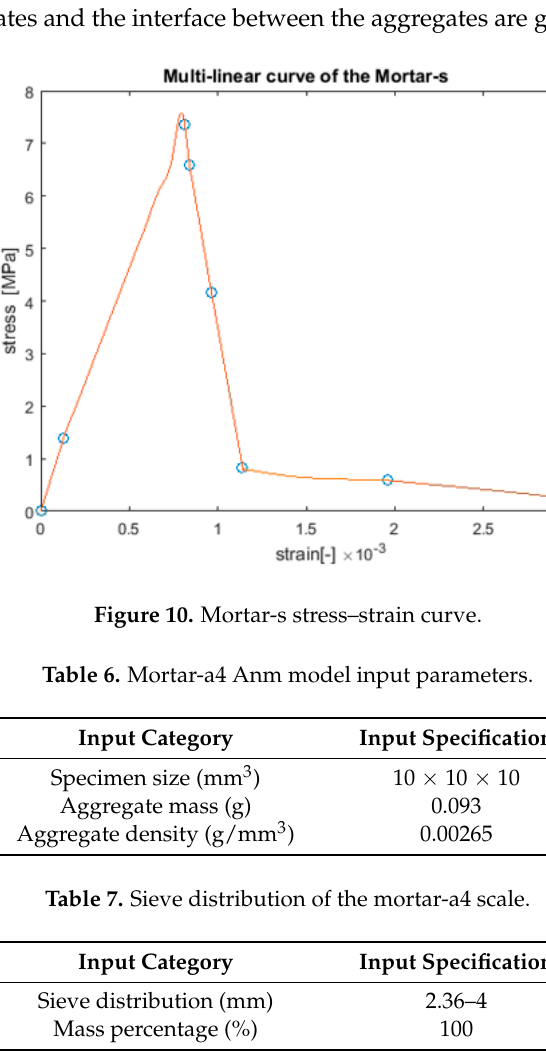
Table 5. Sand and interface material properties (from [41]).